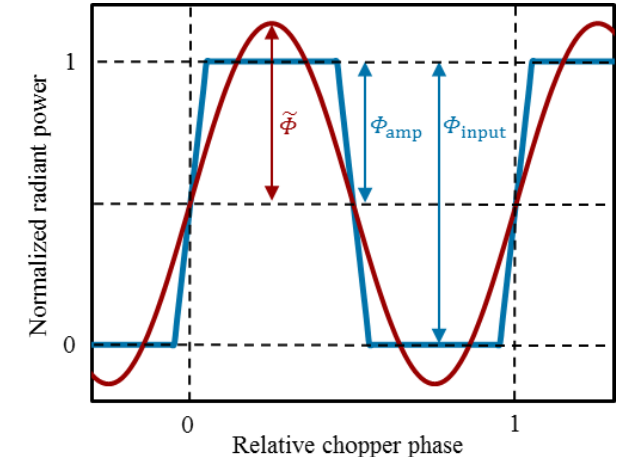
Figure 3. Definition of the physical quantities concerning the time- dependent course of the radiant power. The input value (cid:56) input and amplitude (cid:56) amp of the chopped radiant power (blue) and the related amplitude (cid:101) (cid:56) of the fundamental component (red) are shown.